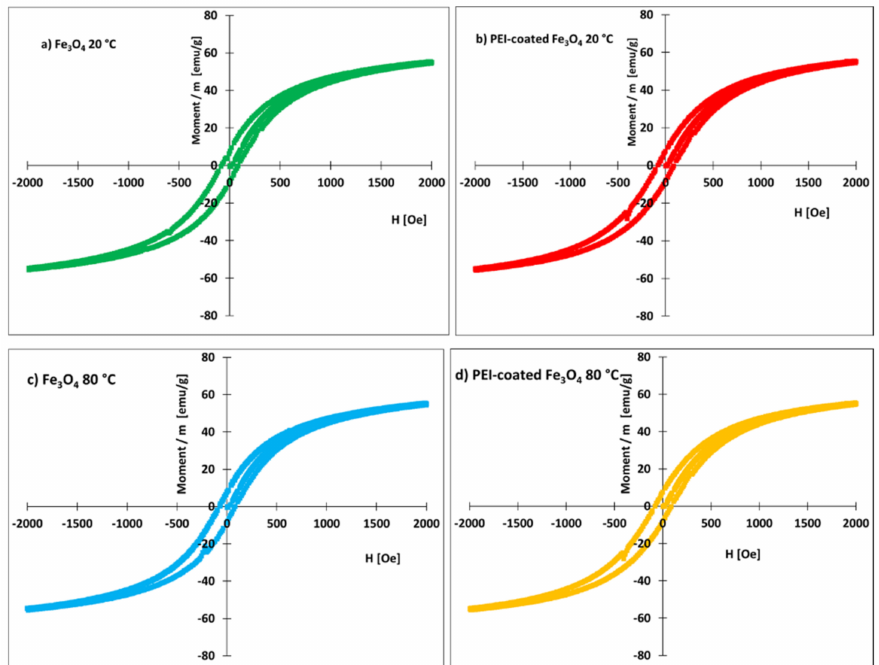
Figure 5. Magnetization curves of prepared nanomaterials.